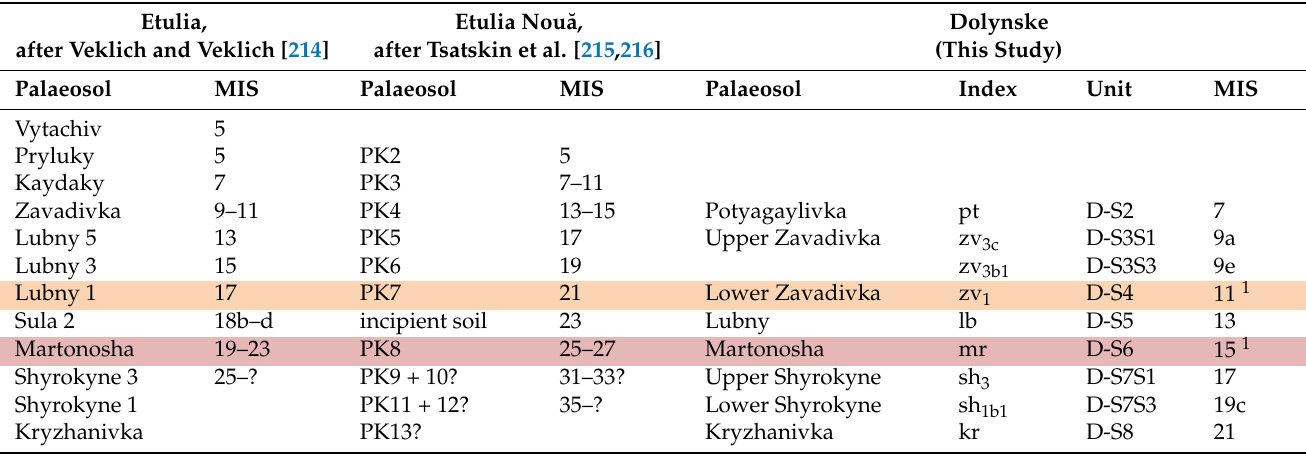
Table 1. Chronostratigraphic models proposed for the Dolynske and nearby loess